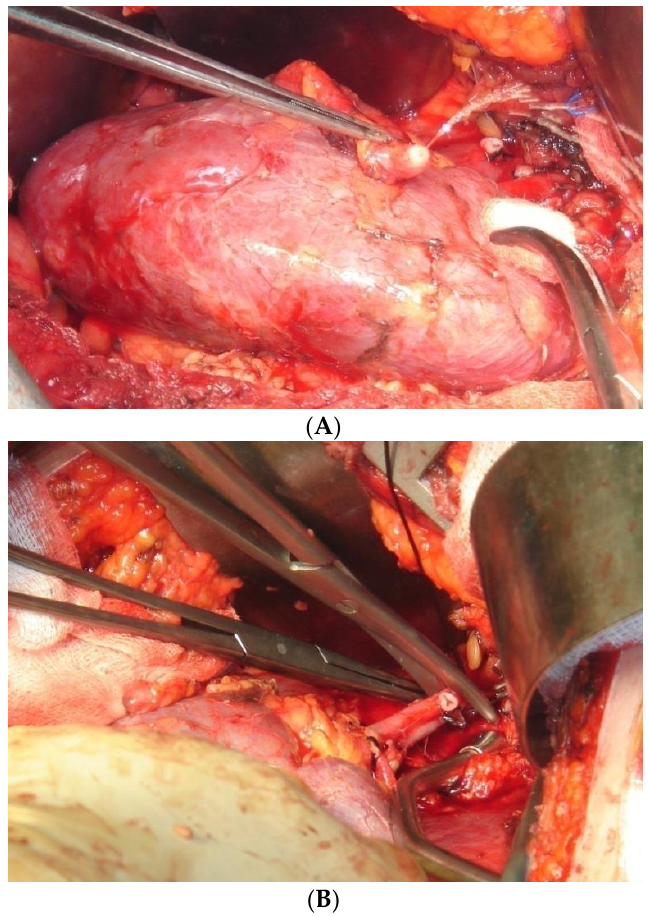
Figure 3. Port placement for laparoscopic donor nephrectomy (LDN). ( A ) Ligation of the ureter. ( B ) Ligation of the renal